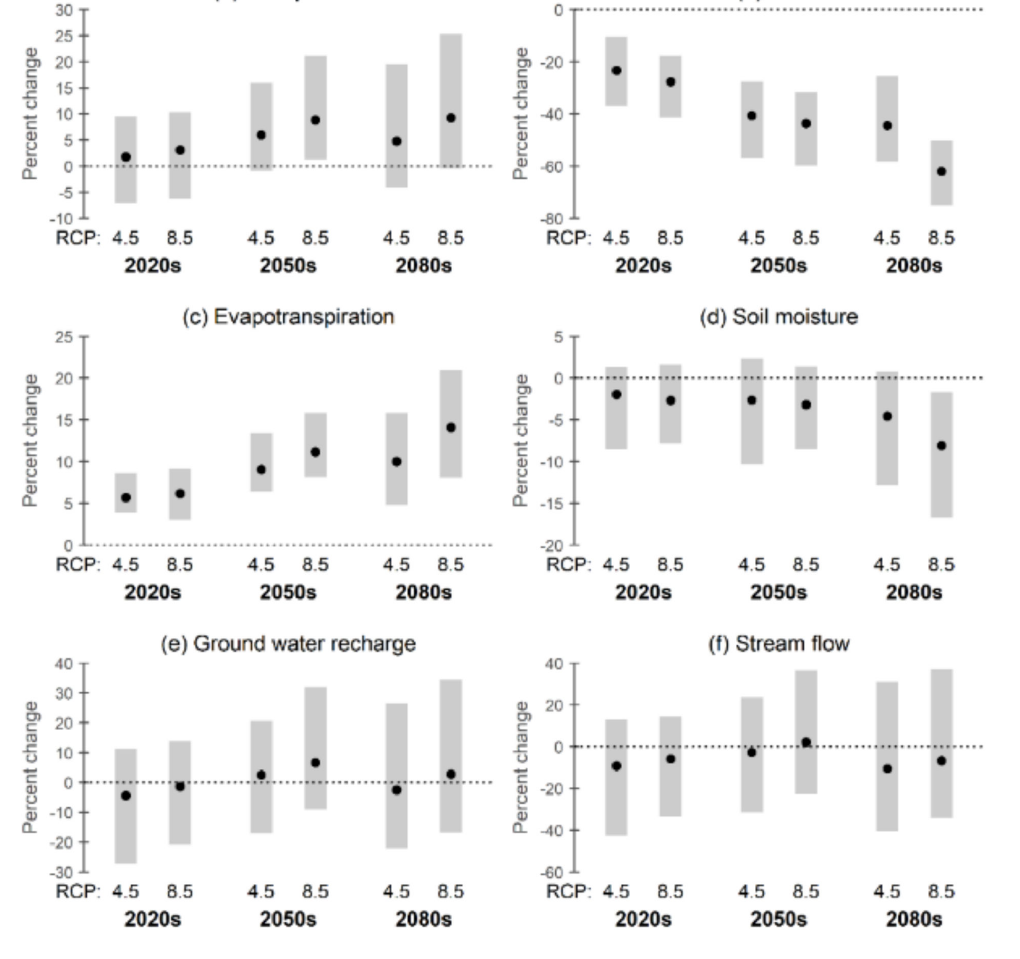
Figure 3. Projected percent change in annual ( a ) precipitation, ( b ) precipitation falling as snow, ( c ) actual evapotranspiration, ( d ) soil moisture, ( e ) ground water recharge, and ( f ) stream flow (at the basin outlet) from the 10-member GCM ensemble for representative concentration pathways (RCPs) 4.5 and 8.5. Gray shading represents the ensemble spread; black circles show the ensemble mean; dotted lines highlight the historical baseline (1971–2000). For the three future periods: 2020s = 2011–2040; 2050s = 2041–2070; and 2080s = 2070–2100. See Table S11 for the tabular